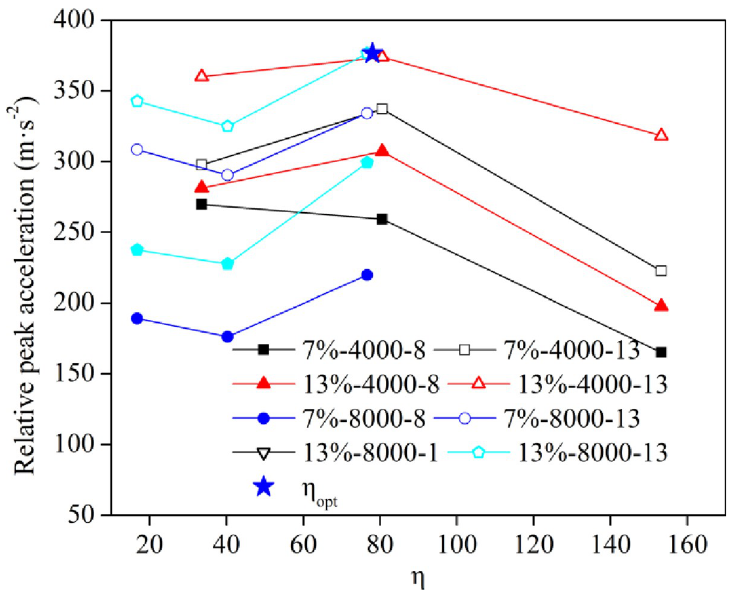
Fig 12. Curves of the relative peak acceleration for different tamping